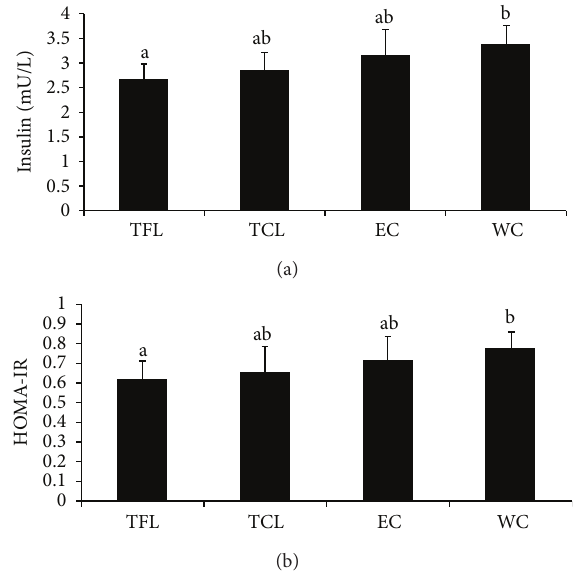
Figure 2: TFL and TCL consumption and plasma insulin and HOMA-IRlevels.(a)EffectofTFLandTCLconsumptiononplasma insulin; (b) Effect of TFL and TCL consumption on